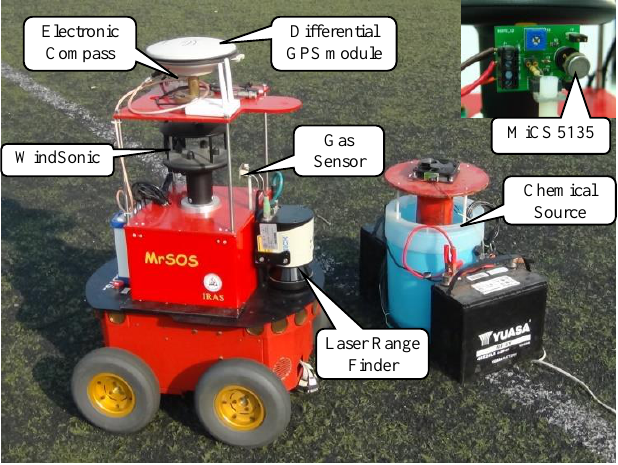
Figure 4. Experimental platform: the wheeled mobile robot MrSOS and the onboard sensors. An enlarged view of the gas sensor (MiCS 5135) is shown at the top right corner.